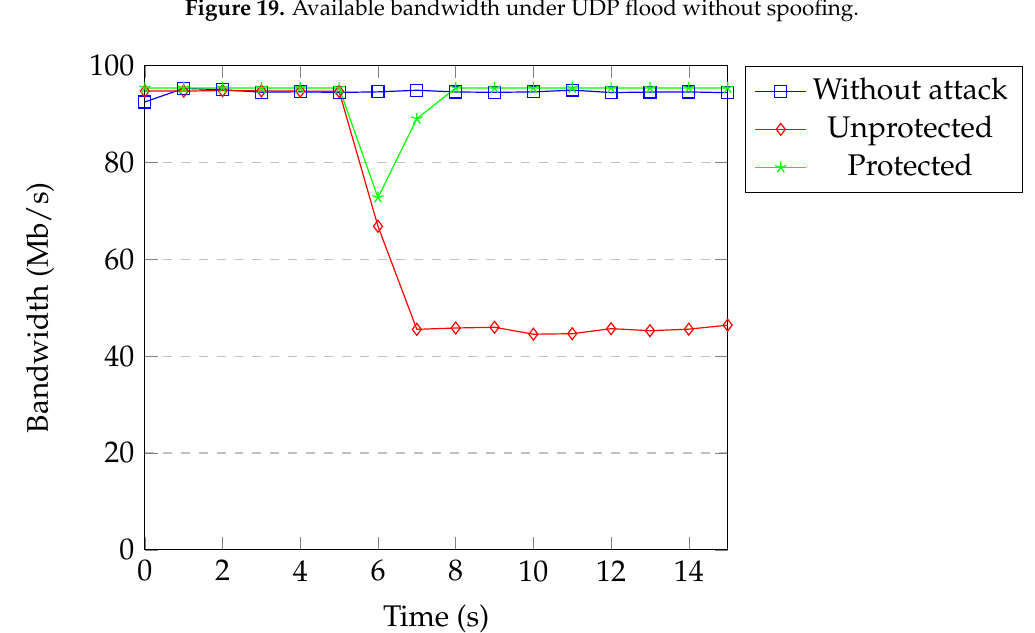
Figure 19. Available bandwidth under UDP flood without spoofing.